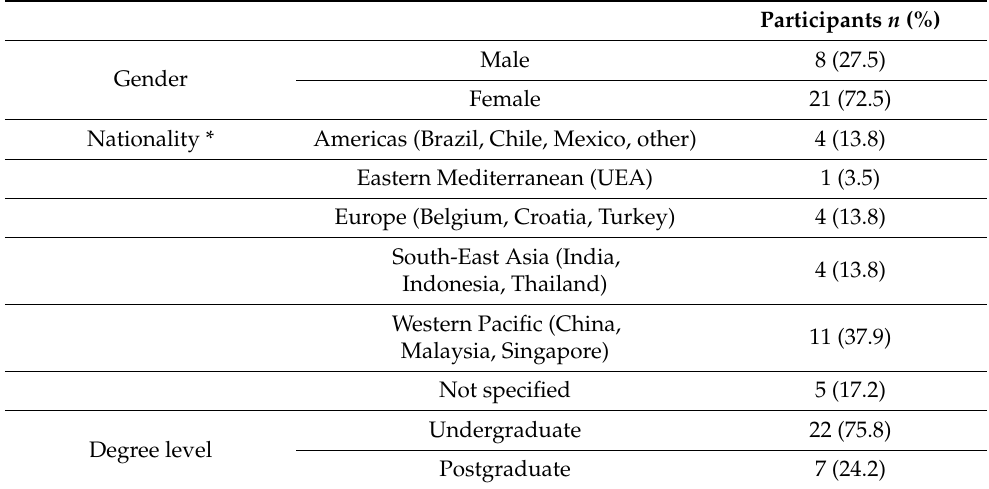
Table 1. Characteristics of international students ( n =